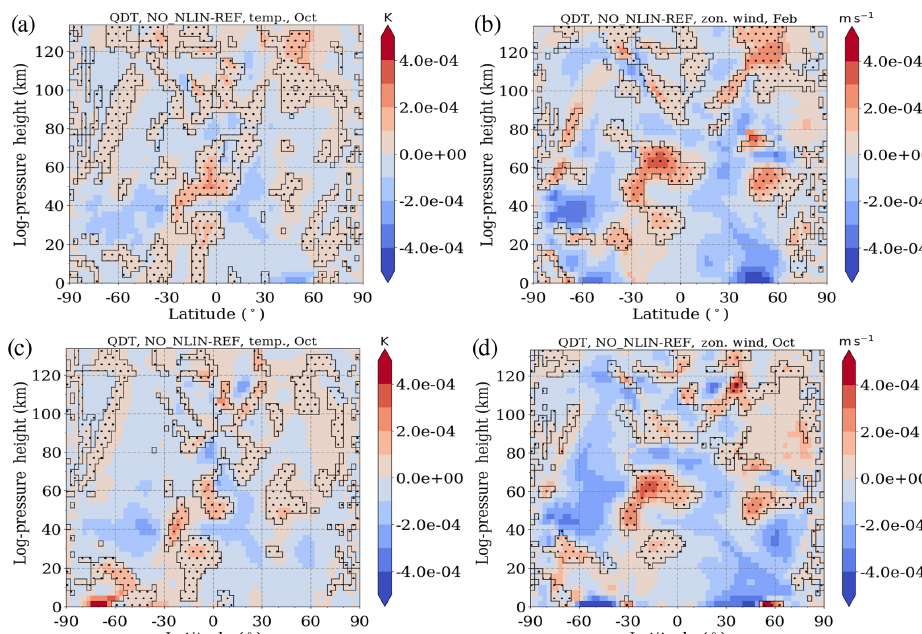
Figure 9. Difference of QDT amplitudes between NO_NLIN and REF simulation, scaled by exp [− z( 2 H) − 1 ] . Red denotes larger NO_NLIN simulation amplitudes, and blue denotes larger REF simulation amplitudes. Areas of destructive interference (120 ◦ ≤ (cid:49)(cid:56) ≤ 240 ◦ ) between NLIN and SOL phases are hatched. Panels (a) and (c) show temperature, and panels (b) and (d) show zonal wind for (a, b) February conditions and (c, d) October conditions.